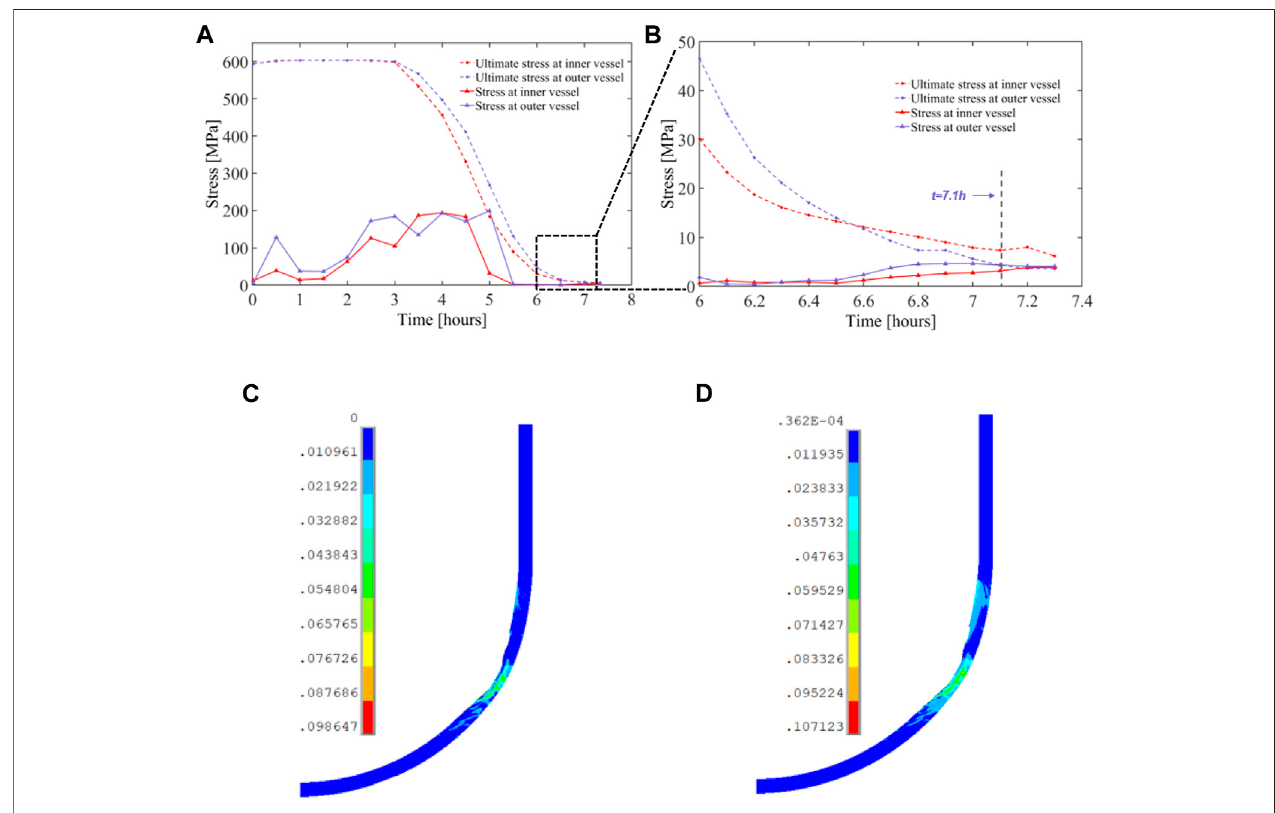
FIGURE 13 | Comparison of von Mises stress of the vessel and SA533B1 ultimate stress at the critical regions for the SBO + LOCA case; (A) region B * and (B) zoomed-in version of region B * after 6 h. The strain distribution of the vessel at time = 7.1 h for the SBO + LOCA case; (C) equivalent creep strain and (D) total strain.